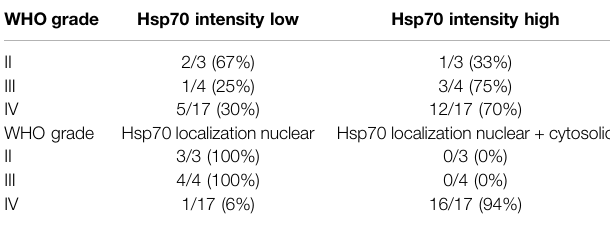
TABLE 2 | Correlation of glioma grading (grade II, III, IV) with the Hsp70 staining intensity(low vs.high)and Hsp70localization(nuclear